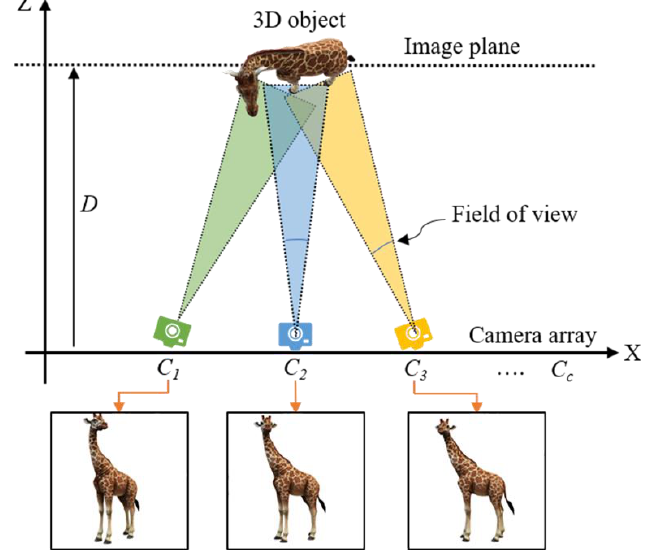
Figure 2. Geometry used for capturing perspectives by the re-centering camera model.